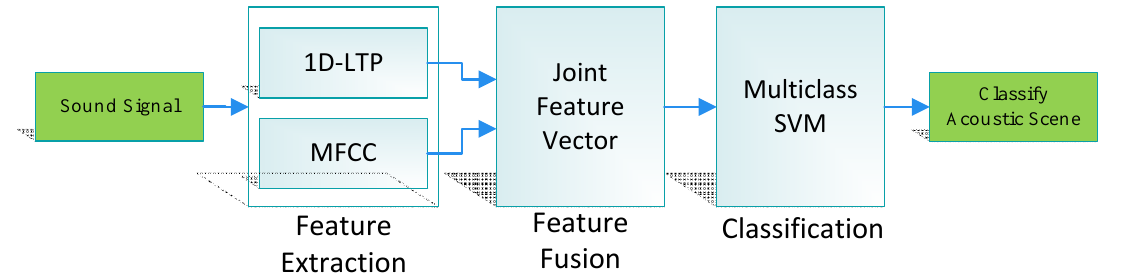
Figure 1. System Architecture for Acoustic Scene